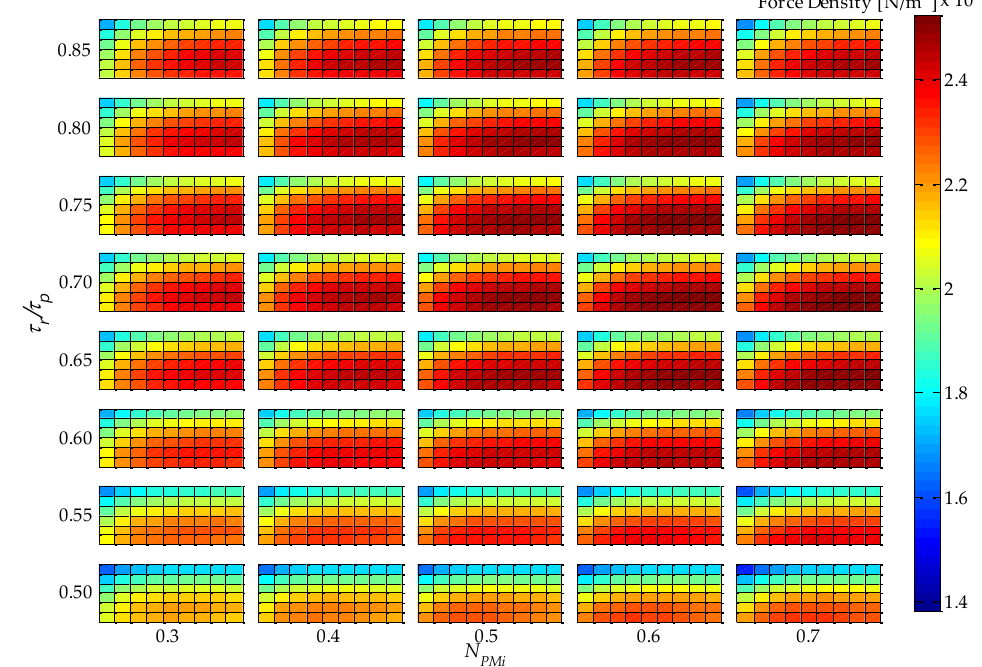
Figure 12 . Results of force density for effective current density according to Figure 11 of the coupled design for four parametric variables: τ r / τ p , N PMi , N CPMs , and n form .